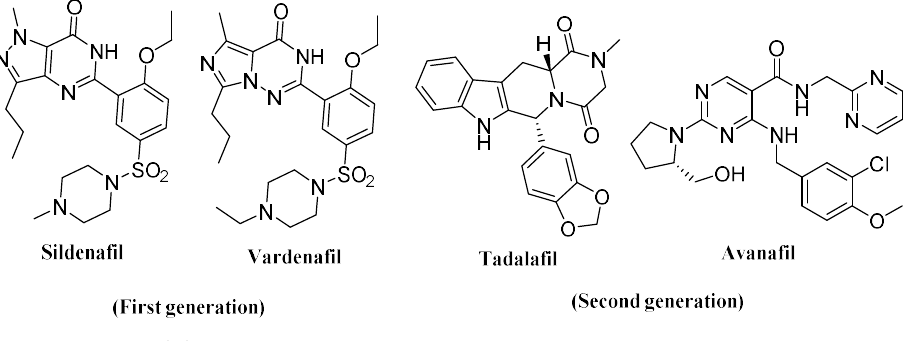
Figure 1. PDE5 inhibitors.